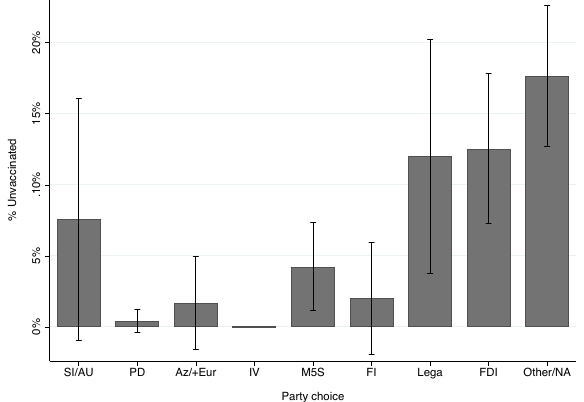
Fig. 3 Political Partisanship and Vaccination Status. Bars presents the percentage unvaccinated by supporters of each party. None of the 17 supporters of Italia Viva ( IV ) reported being unvaccinated. I-bars present 95% con fi dence